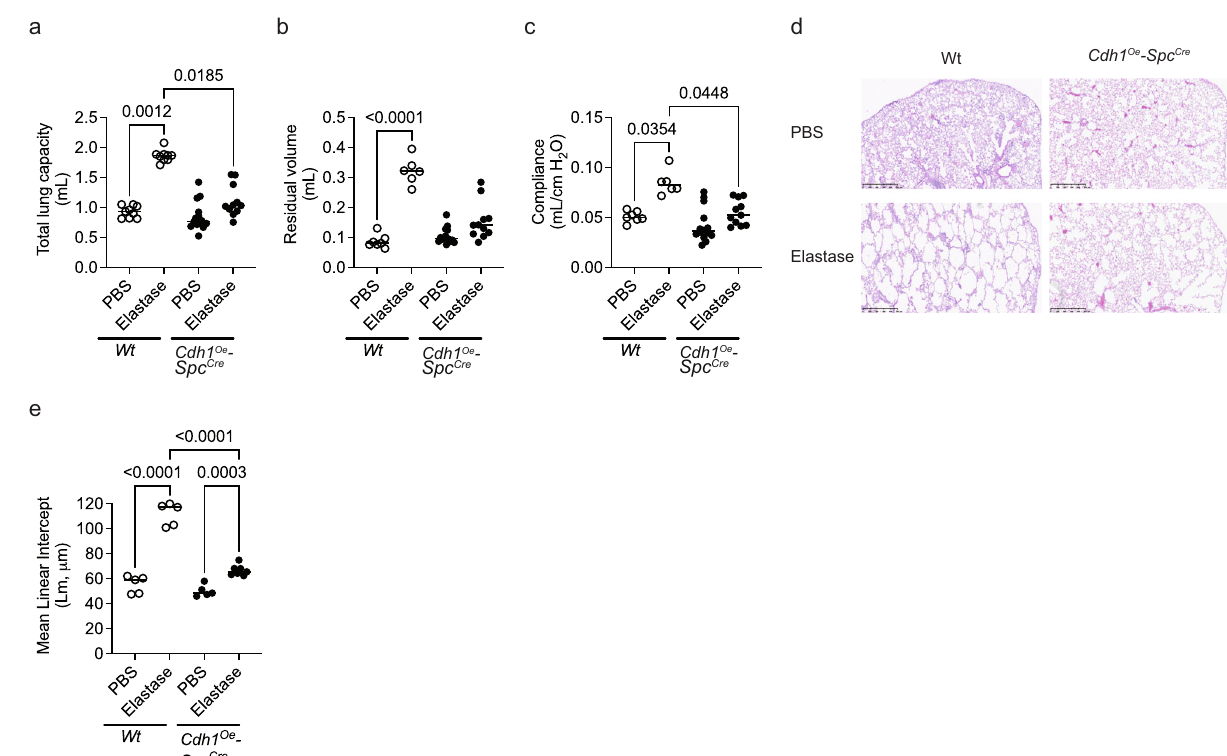
Fig. 8 Overexpression of E-cadherin in AT2 protects against elastase-induced injury. No difference in a total lung capacity, b residual volume, and c compliance among mice overexpressing E-cadherin in AT2 cells ( Cdh1 Oe -Spc Cre ) instilled with elastase as compared to Cdh1 Oe -Spc Cre with PBS and wild- type (Wt) instilled with elastase. d H&E staining (representative image) and e quantitative MLI showed a reduction in airspace enlargement as compared to Cdh1 Oe -Spc Cre instilled with PBS and Wt instilled with elastase. Data are expressed as median bars and generated from 5 to 14 mice. Kruskal-Wallis test, followed by Dunn ’ s multiple comparison test was performed . P < 0.05 were considered statistically signi fi